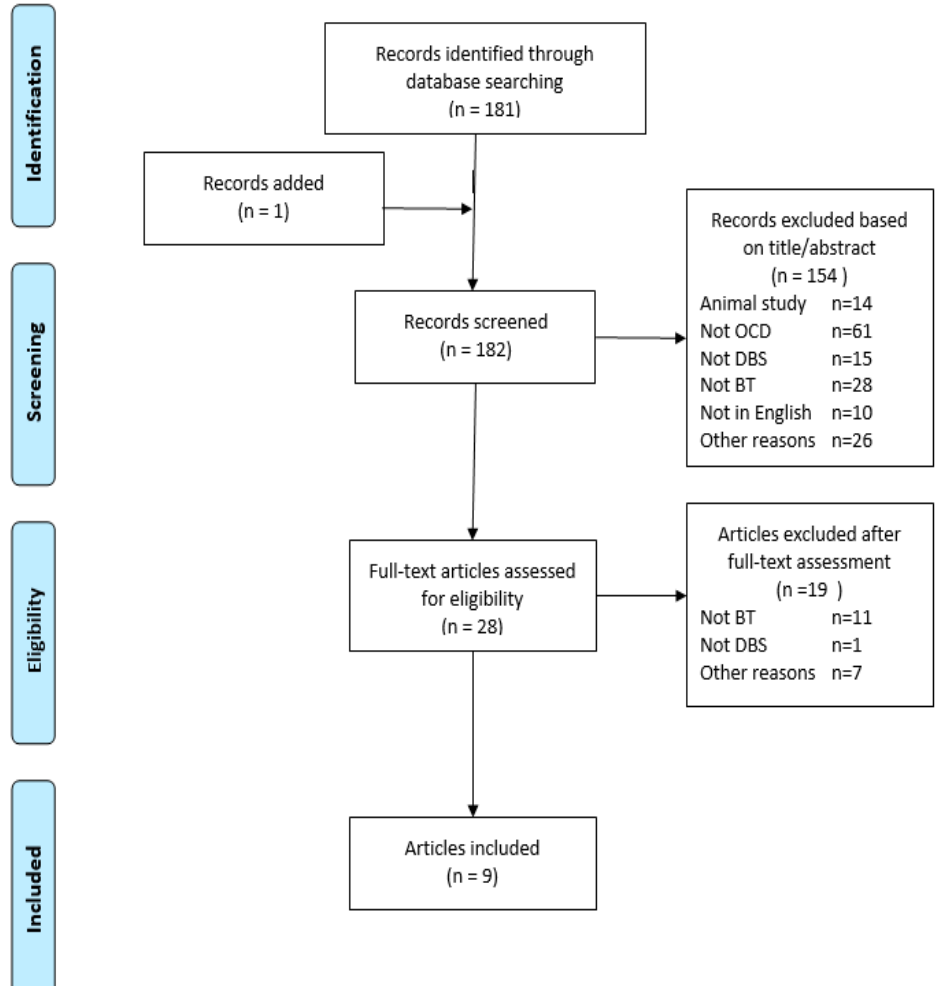
Figure 1. PRISMA flow diagramme. Abbreviations: OCD = obsessive compulsive disorder; DBS = deep brain stimulation; BT = behavioral therapy.